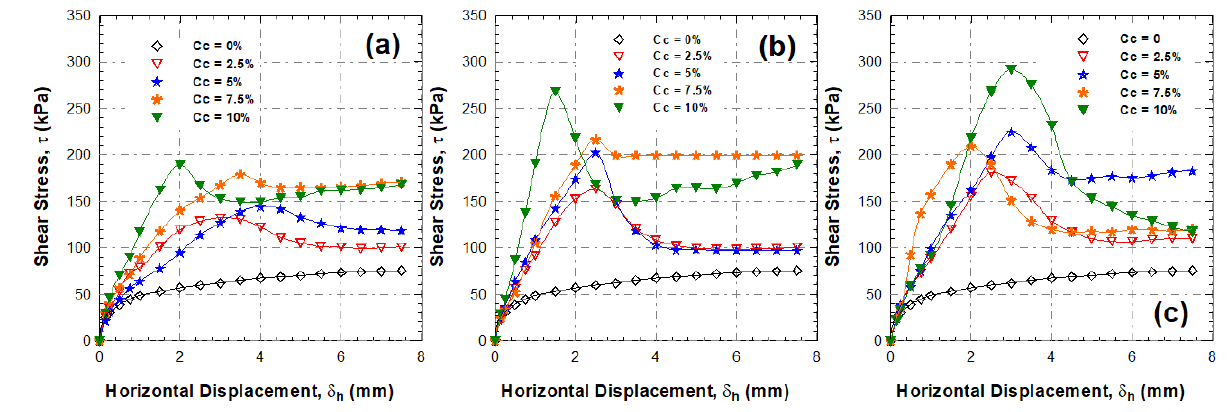
Figure 9: Influence of curing time on shear strength of cemented sand ( σn = 100 kPa), (a) after 7 days, (b) 14 days, (c) 28 days.